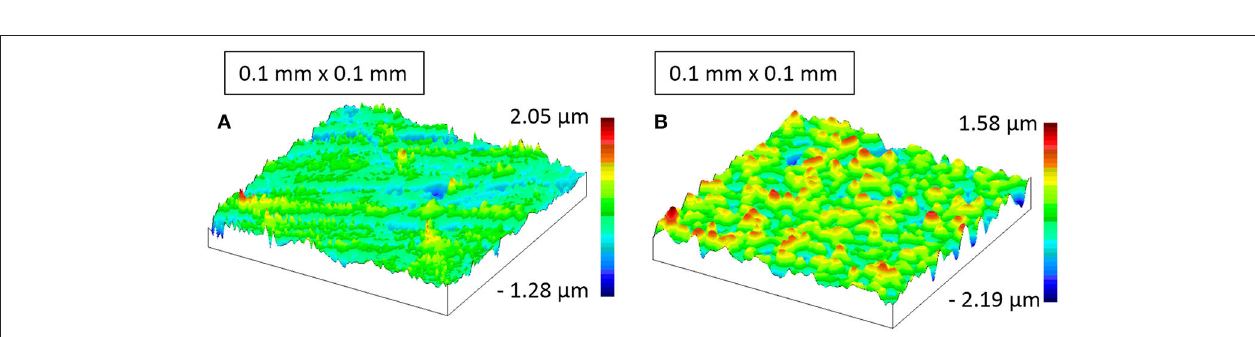
FIGURE 8 | (A) Honed surface (Sdq = 0.197; Sdr = 1.839%); (B) Electric discharge machined surface (Sdq = 0.182; Sdr = 1.680%).